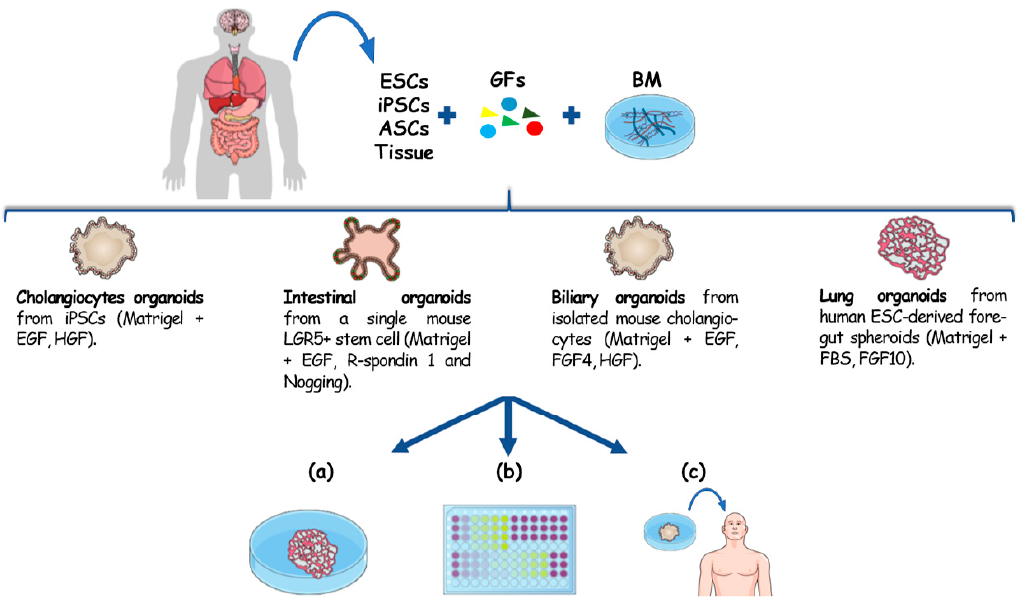
Figure 1. Organoids establishment from di ff erent cell sources and their downstream applications. Organoids can be originated from di ff erent sources: ESCs, ASCs, iPSCs and primary tissue. The embedding of these cells in a basal membrane (BM), mostly represented by Matrigel, with appropriate growth factors has been reported to give rise to cholangiocytes [9] intestinal [3], hepatobiliary [10] organoids and lung [7]. For the capability to recapitulate 3D architecture, genotype and the histomorphology of the in vivo counterpart these constructs can be exploited for ( a ) disease modelling, ( b ) drug screening and precision medicine. Given their genome stability and the possibility to establish an organotypic culture with patient cells, organoids also showed to be a promising tissue source for regenerative medicine ( c